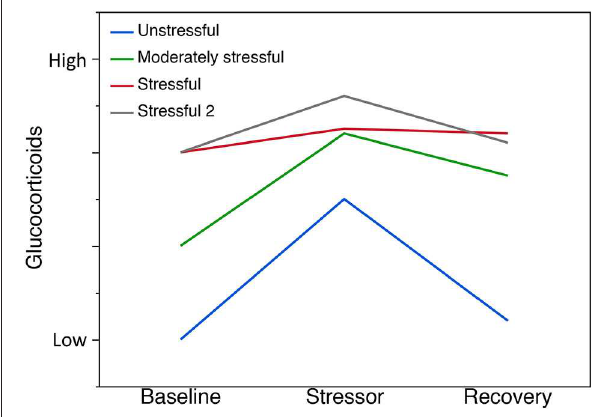
FIGURE 1 | Capacity to cope with environmental stressors. A schematic illustration of putative stress responses. Here, we present scenarios based on the expectation of chronic exposure in benign (unstressful), moderate stress, or severe stress environments. (Note: based on the origin of the study populations, the exact responses may take different forms). The ability to modulate the stress response provides an indication of the ability of a population to cope with stressors. Recovery indicates how quickly individuals in a population can activate negative feedback after the stressor has passed. For example, we propose that populations in unstressful environments will show, on average, low baseline GC, high stress response to an external stressor and high recovery (blue line). In the moderately stressful environment, populations may have higher average baseline GC, show a strong stress response to an external stressor but have a slower recovery (green line). In the stressful environment, populations may have higher average baseline GC, show none or very little stress response to an external stressor and no further change in GCs indicating some level of chronic stress or dysregulation (red line). Alternatively, a population may show the capacity to cope, even when average GCs are high, in the face of a stressful environment (Stressful 2; gray line). Further, GCs could be lower in more stressful